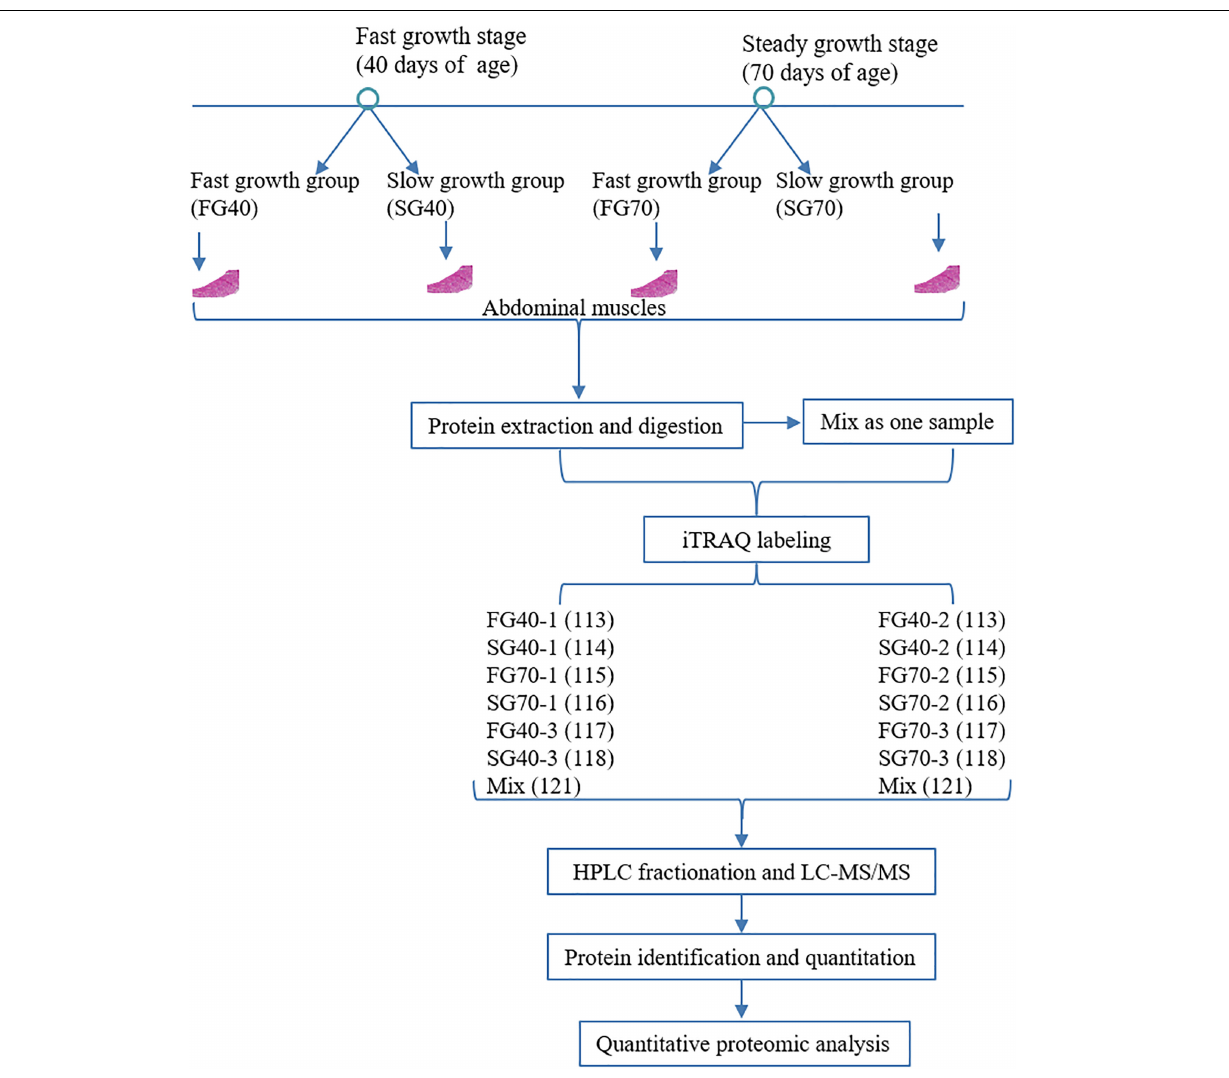
FIGURE 1 | Workflow of the proteomic analysis performed to examine the unsynchronized growth of M. japonicus